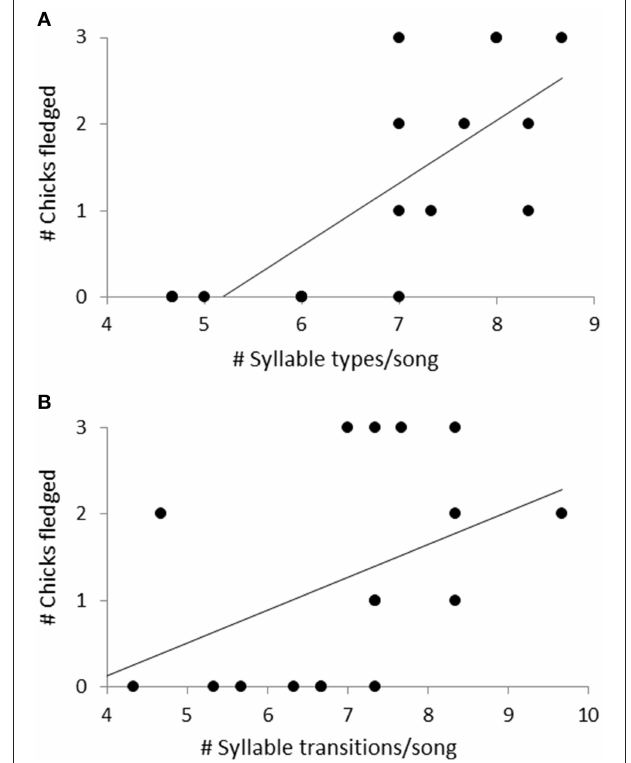
FIGURE 8 | The relationship between the number of chicks fledged and (A) the number of syllable types per song, and (B) the number of transitions between syllable types per song. Linear regression lines show direction of the relationship. These two parameters were associated with the PC2 scores of a PCA analysis looking at the effect of five song parameters on female reproductive